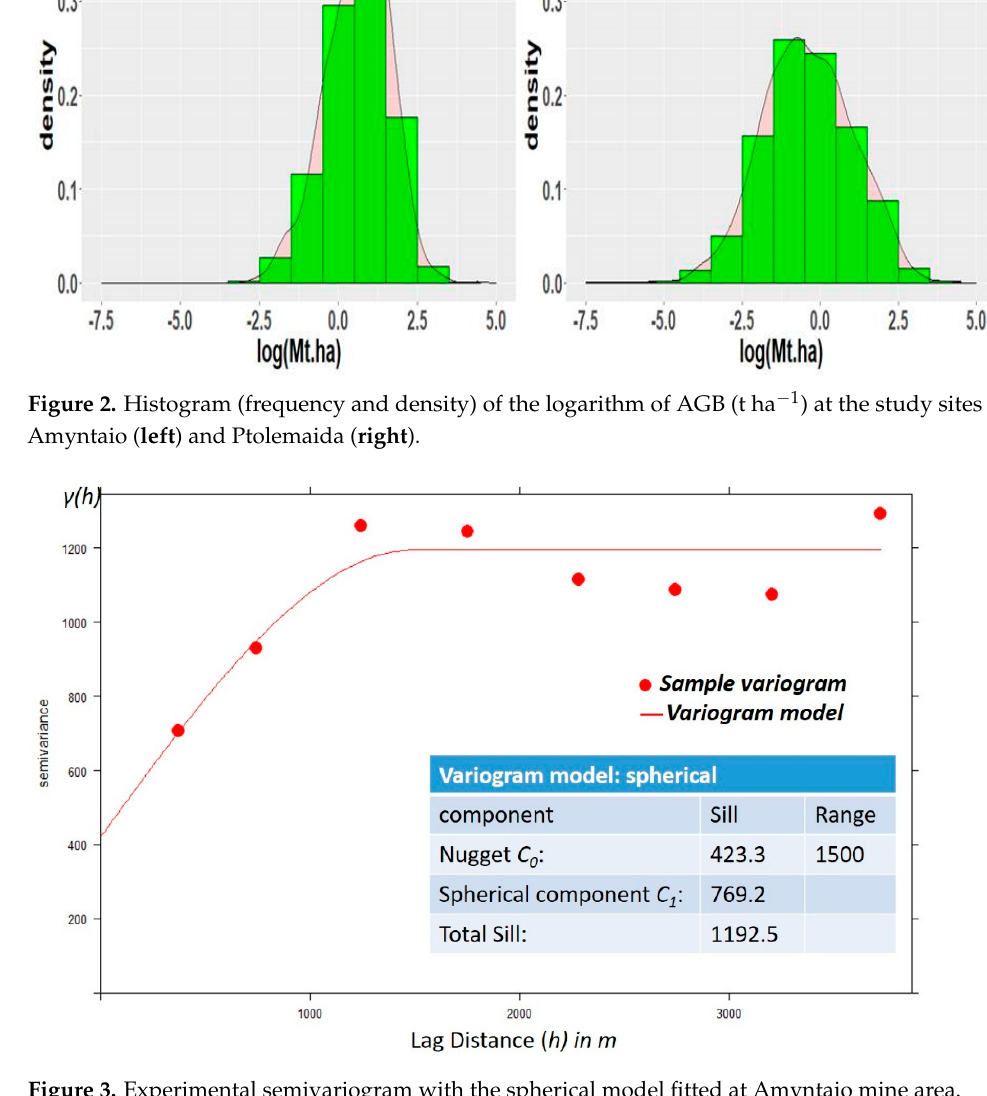
Figure 2. Histogram (frequency and density) of the logarithm of AGB (t ha − 1 ) at the study sites of Amyntaio ( left ) and Ptolemaida ( right ).